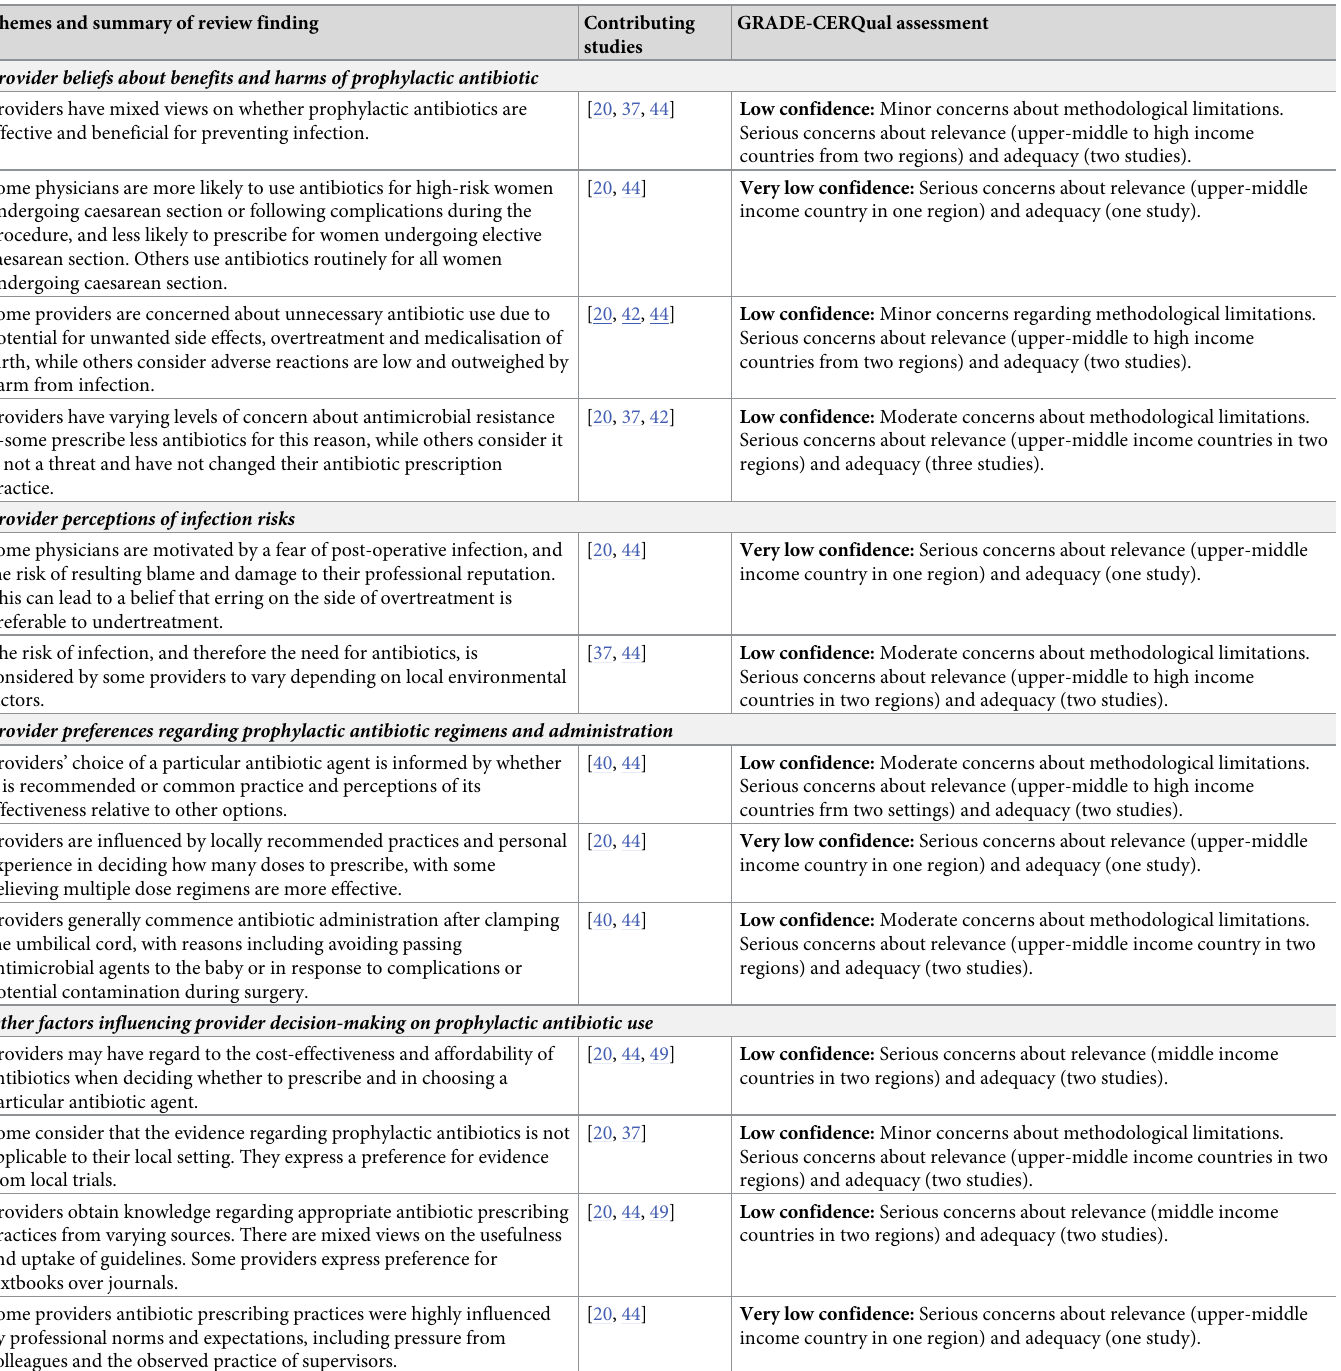
Table 2. Summary of qualitative findings on perspectives and experiences of healthcare providers on use of peripartum prophylactic